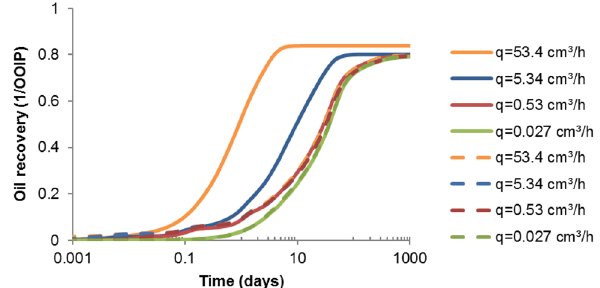
Fig. 16 Comparison of oil recovery versus time curves of the